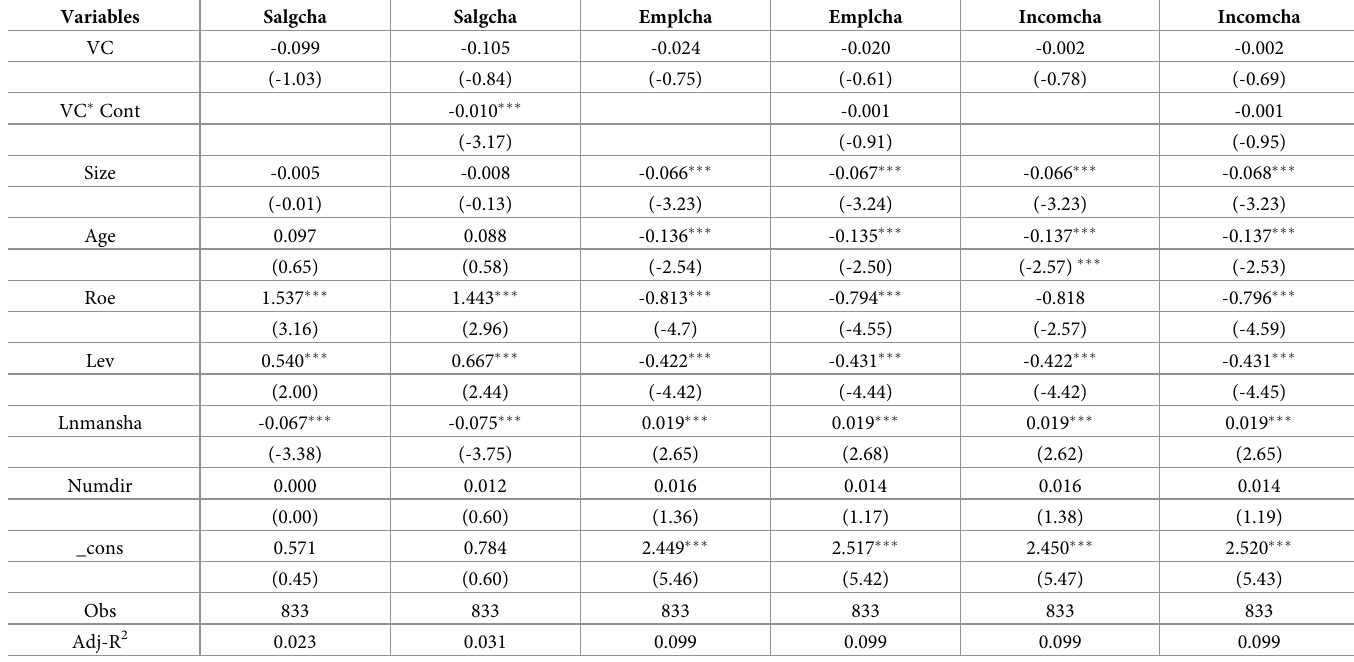
Table 7. Test of moderating effect of degree of control right of replacement agent indicator.